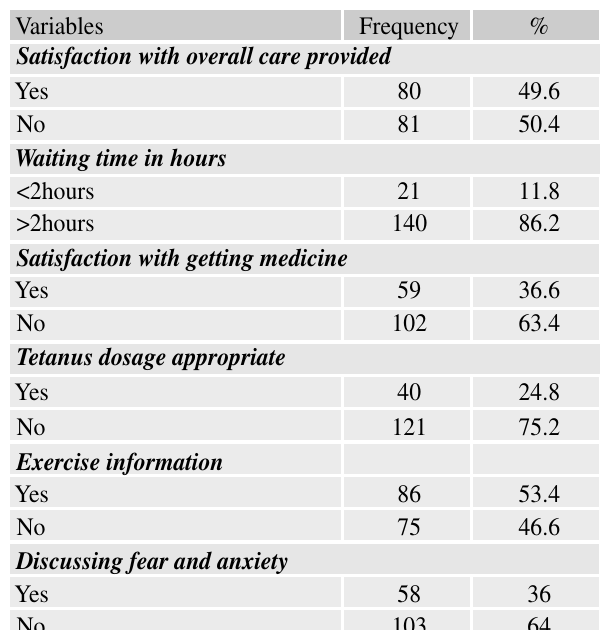
Table II: Distribution of respondents based on satisfaction level variables